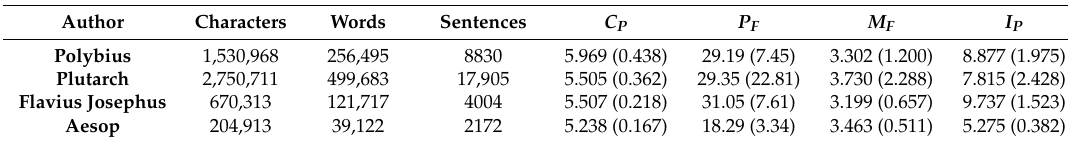
Table 17. Examples of classical Greek literature. Totals of characters, words, sentences; average number of characters per word C P , words per sentence P F , interpunctions per sentence (also, number of word intervals ) M F , words per interpunctions (word interval) I P . The number between parentheses gives the standard deviation for text blocks of 500 words.